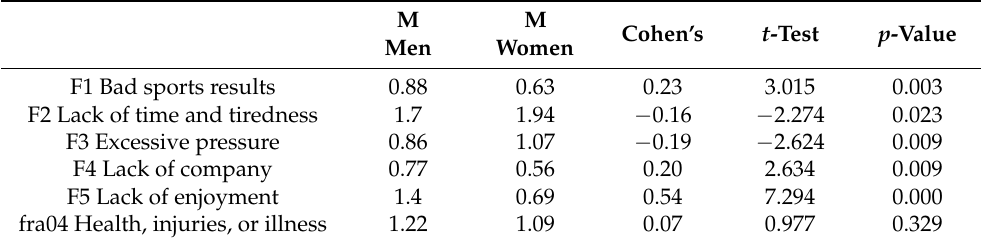
Table 4. Dropout reasons based on gender.